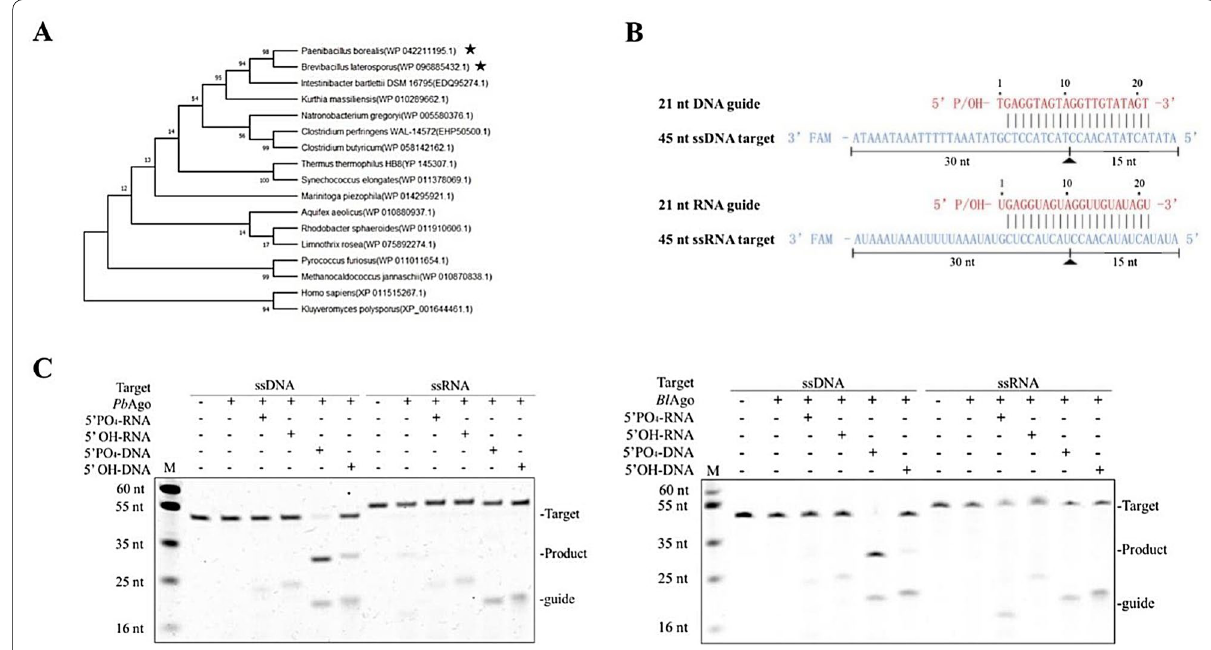
Fig. 1 Pb Ago and Bl Ago exhibit DNA-guided DNA cleavage activity at 37 °C. a Neighbor-joining phylogenetic tree analysis of Pb Ago and Bl Ago and characterized pAgos. The numbers at the nodes indicate the bootstrap values for neighbor-joining analysis of 1000 resampled data sets. The scale bar represents the evolutionary distance between species. The numbers in parentheses represent the sequence accession numbers in the NCBI database. b Synthetic DNA or RNA guides (red) and targets (blue). The predicted cleavage positions are indicated with a black triangle; black lines indicate the predicted 15 and 30 nt cleavage products. c Cleavage activity assays of Pb Ago and Bl Ago with FAM-labeled DNA or RNA